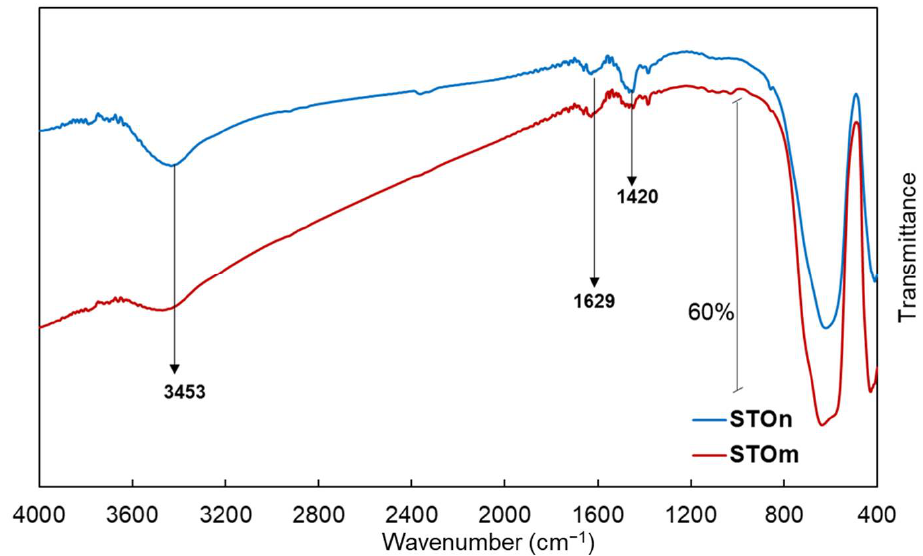
Figure 6. FT-IR spectra of STOm (red line) and STOn (blue line).